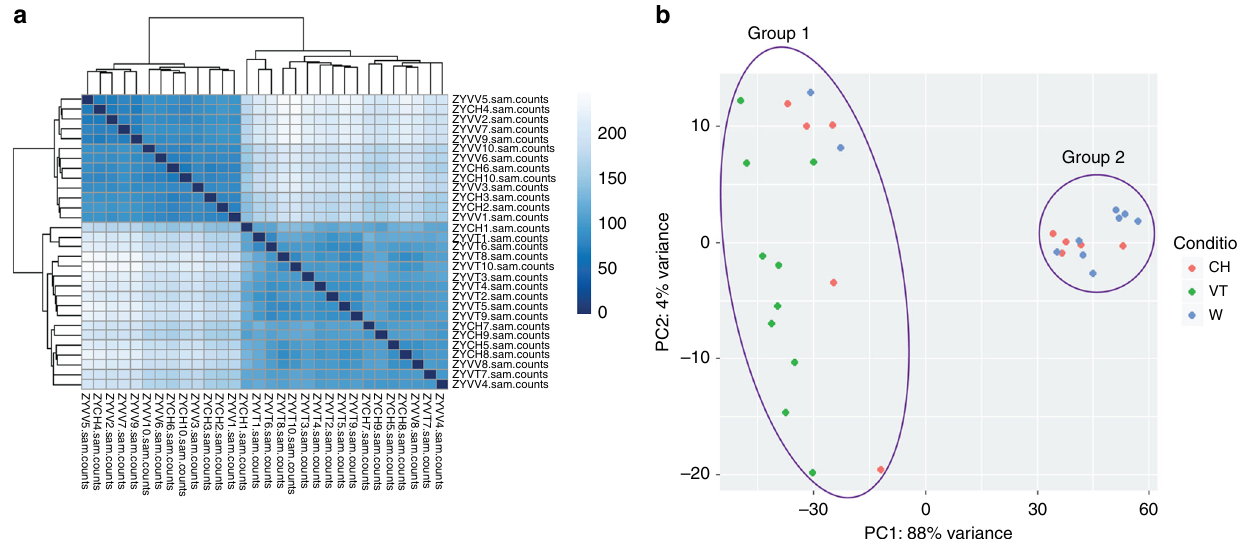
Fig. 7 Comparison of the transcriptomes identi fi ed by Cel-seq for in vivo (VV) , in vitro (VT) and on chip (CH) zygotes. a Heat map comparing all zygotes. b Principal component analysis (PCA) of the transcriptomes for in vivo ( VV , blue), in vitro ( VT , green) and on chip ( CH , red) zygotes; PC1 and PC2 represent the top two dimensions of the differentially expressed genes among the zygote groups. Note, from a and b , the division between two main clustering groups, Groups 1 and 2 in ( b )